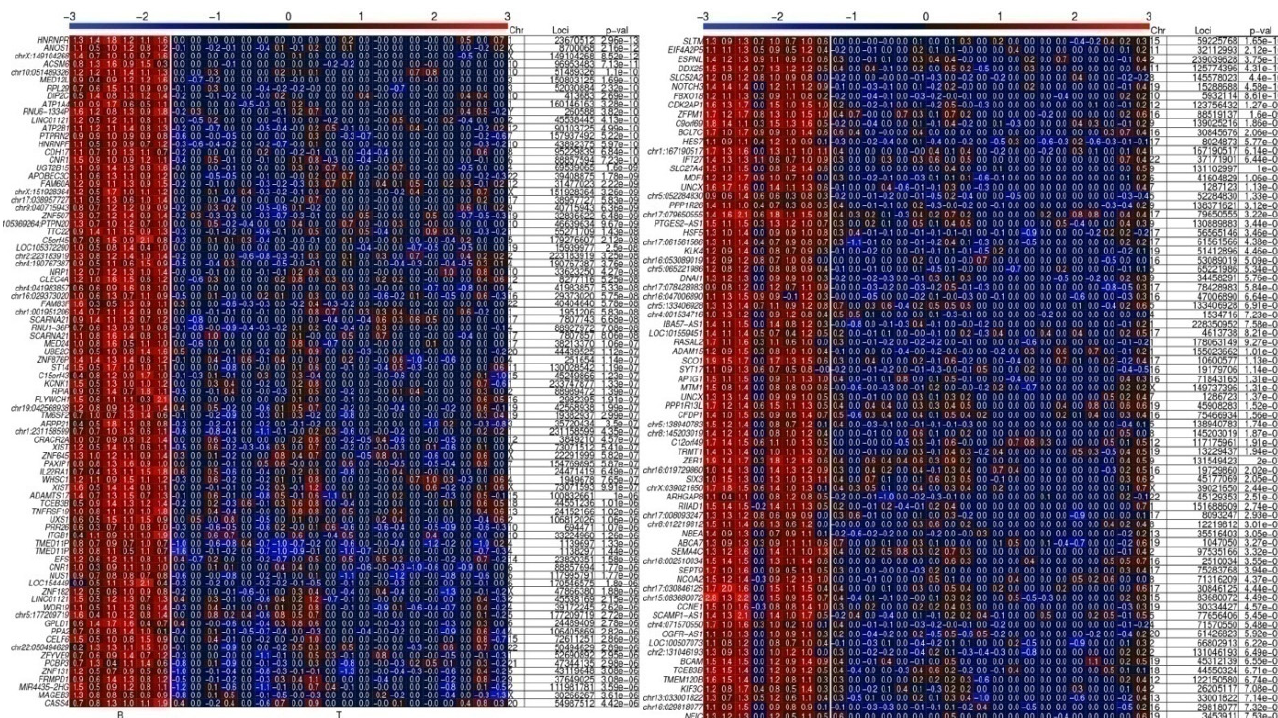
Figure 4. DNA methylation heat maps of CpG-rich DNA probes of 60 nucleotides associated with 5´ gene regions in BPH, PCa-adjacent and PCa tissue samples. Both groups, firstly, 6 tissue samples from BPH prostate glands (B), and secondly, 8 samples of tumor-adjacent healthy-appearing gland tissue (C), were separately analyzed in comparison to the same 20 PCa tumor tissue samples (T). Only the first 75–85 most differentially methylated CpG-rich probes out of approx. 250 hypomethylated genetic regions found in each group are presented. Each rectangle in the heat map stands for one CpG-enriched 60-nucleotides-long probe associated with the named 5 ′ gene region, with the chromosomal location indicated on the right hand side (Chr, start/end). Redder colors correspond to more methylated regions. E.g., the most unmethylated 5 ′ gene regions are light blue. The grade of methylation is also indicated by numbers within the colored rectangles. A higher number corresponds to higher